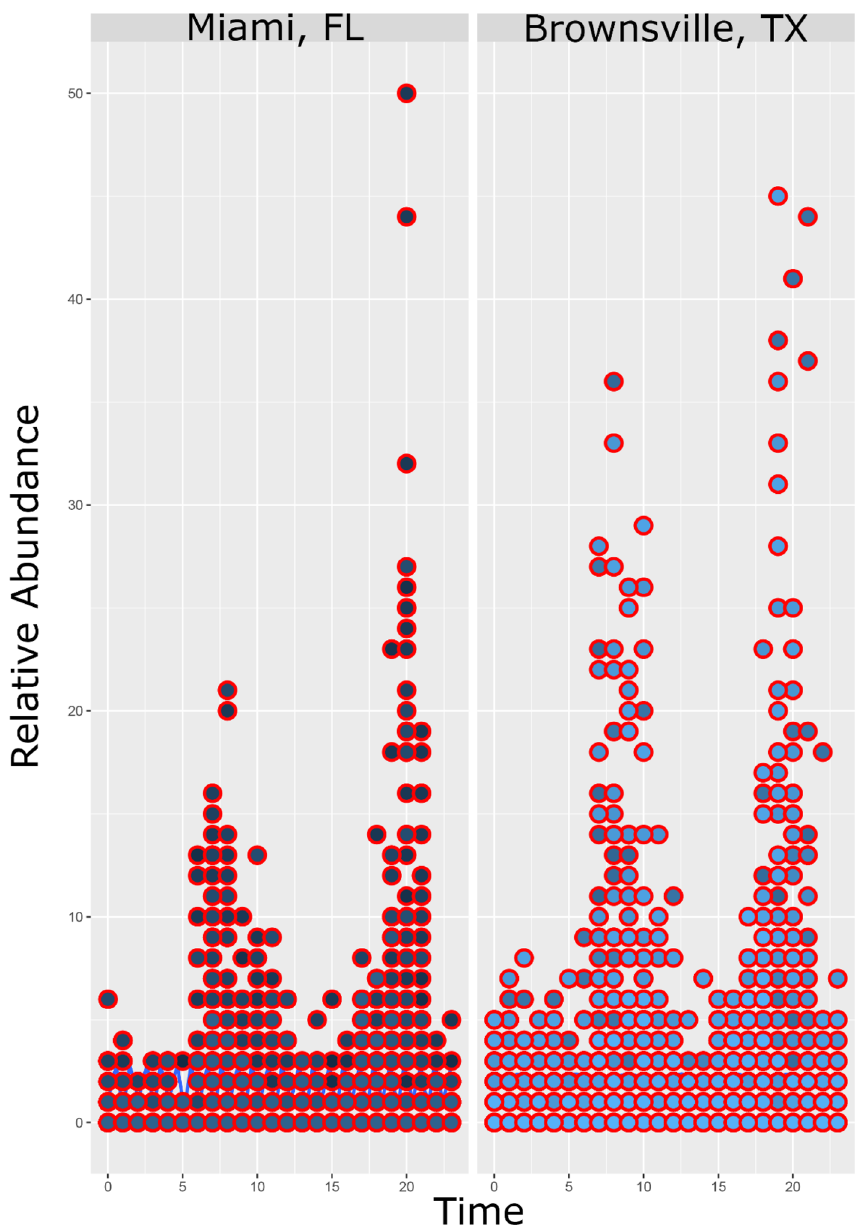
Figure 4. Diel activity patterns of female Ae. aegypti mosquitoes in Miami, Florida and Brownsville, Texas. Relative abundance on the y axis represents the relative abundance of female Ae. aegypti mosquitoes captured per trap per hour throughout the sampling period, May through November 2019